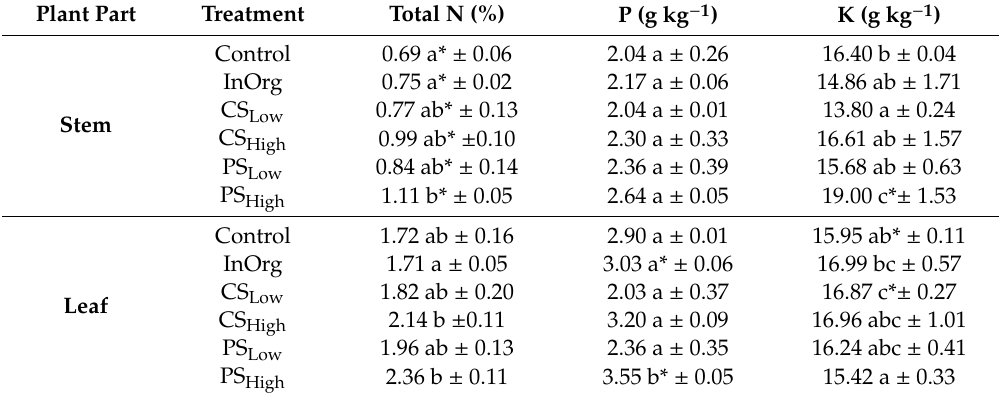
Table 1. Leaf and stem concentrations of total N (%), P (g kg − 1 d.m.) and K (g kg − 1 d.m.) in Rosmarinus o ffi cinalis plants for the fertilization treatments: Control, InOrg, CS Low , CS High , PS Low and PS High . Mean values ± standard errors ( n = 3) are shown. Di ff erent letters indicate significant di ff erences among fertilization treatments ( p < 0.05). Asterisks indicate significant di ff erences between leaf and stem values ( p <